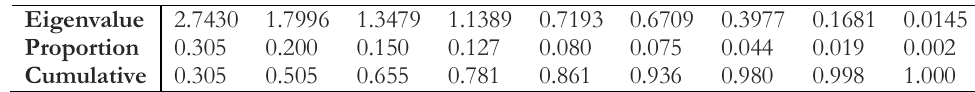
Table 4. Eigen analysis of the Correlation